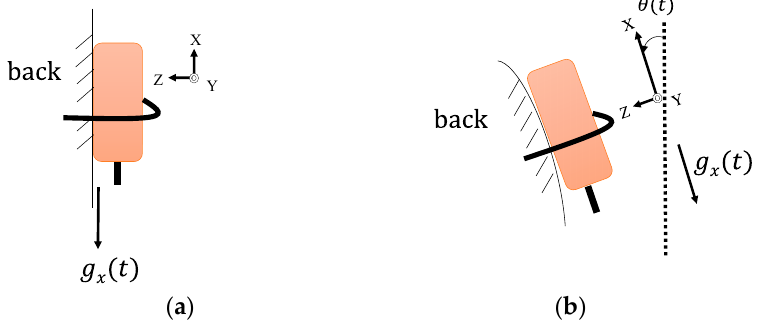
Figure 5. Adjusting for the influence of gravity. The X -axis is a local axis of the tracker, and (cid:1859) (cid:3051) ((cid:1872)) is defined along the X -axis. ( a ) the tracker is worn vertically; ( b ) the tracker is worn with an inclination angle θ((cid:1872)) in plane X-Z.